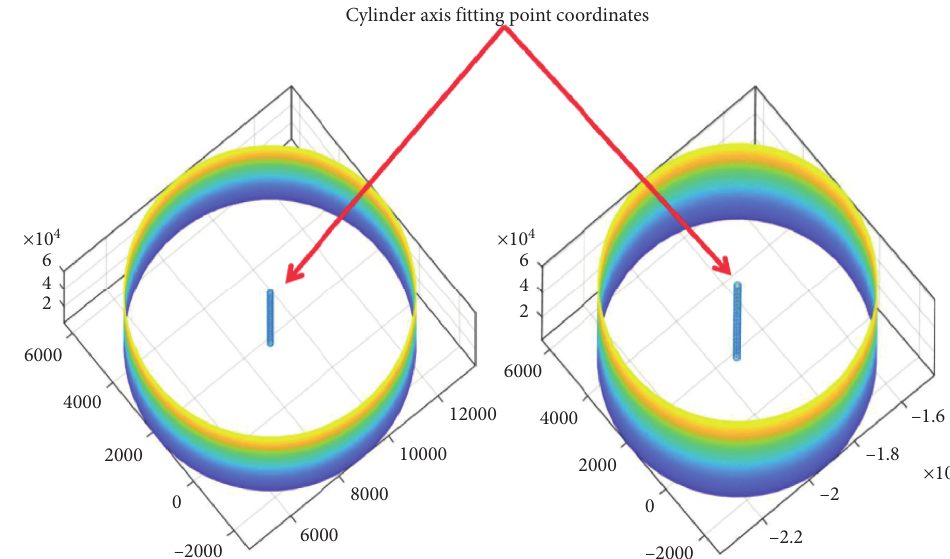
Figure 11: Cylinder axis fitting point coordinates.